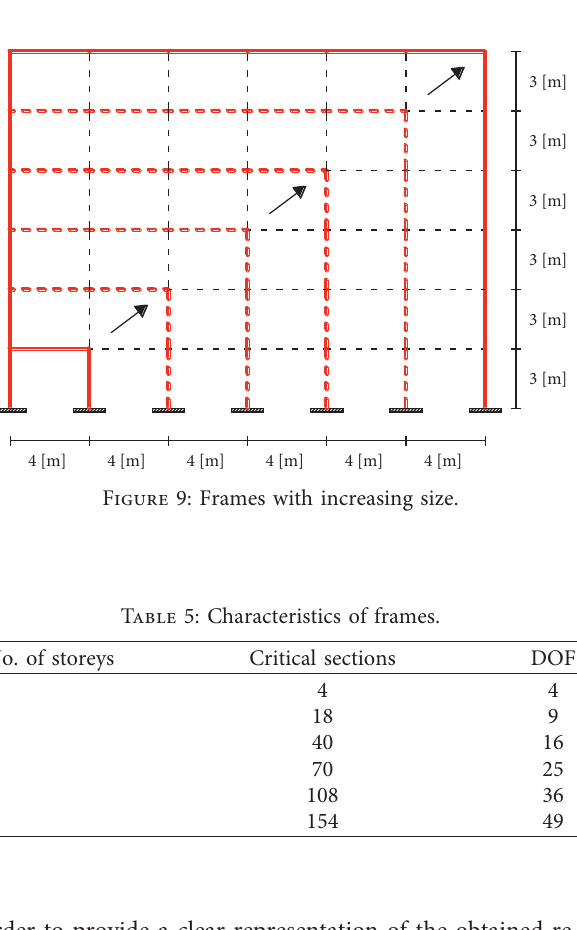
Figure 8: Normalized fitness values for damage with intensity α � 300 located in section 7 (a) and a zoom (b).